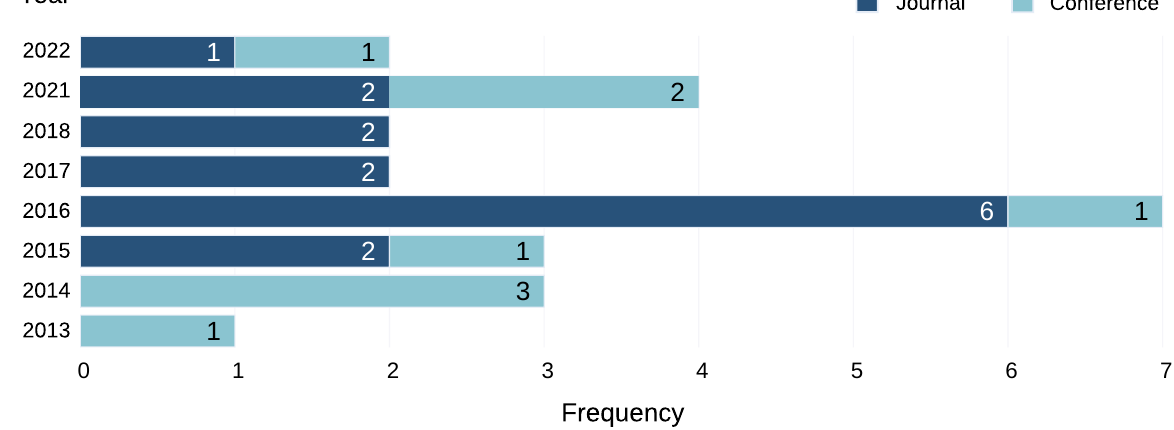
Figure 3. Number of publications per year for the last ten